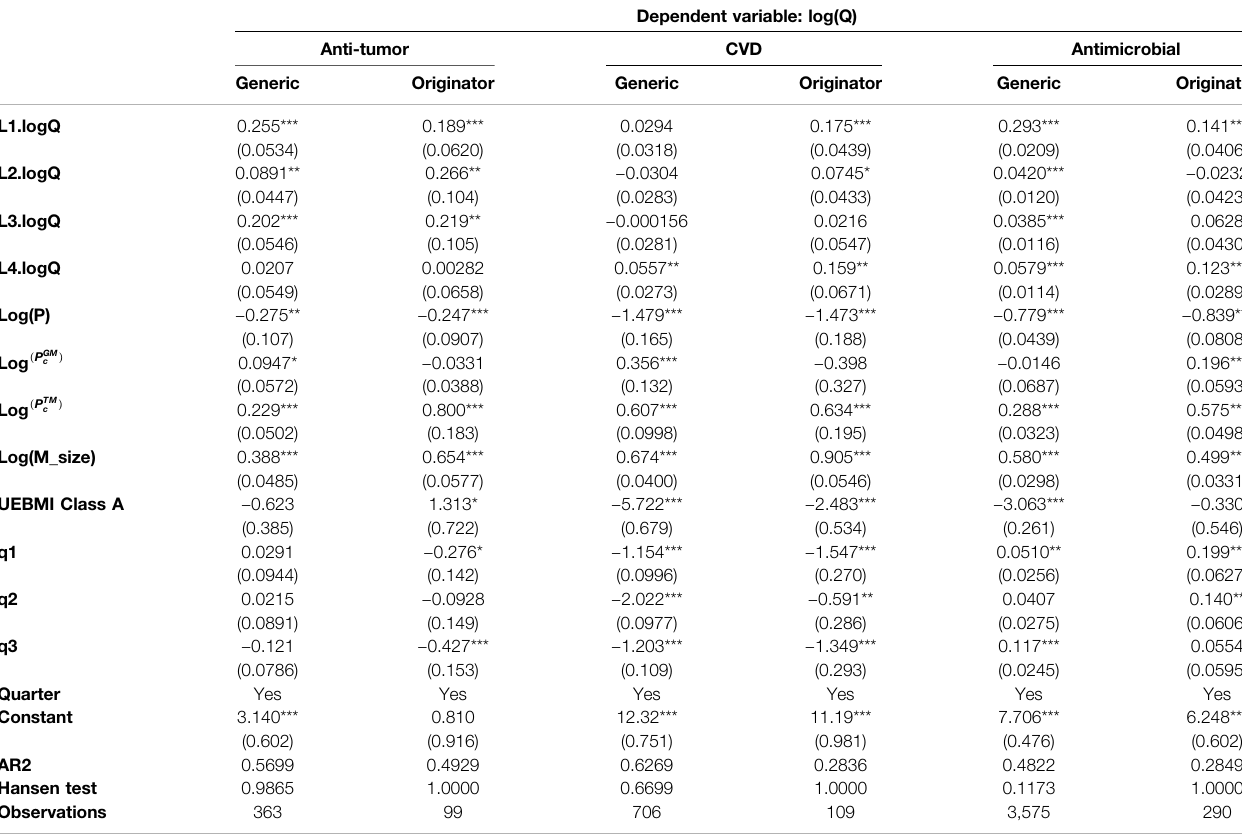
TABLE 4 | Estimates of the demand by products types (generic vs.